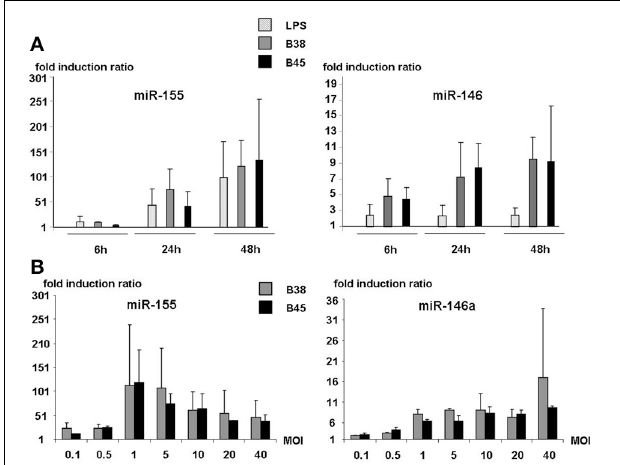
FIGURE 2 | MOI dependence and kinetic analyses of miR-146a and miR155 expression in activated dendritic cells. (A) DCs were either stimulated with E. coli LPS or cocultured with H. pylori strains B38 or B45 at MOI 1 for 6, 24, or 48h. (B) DCs were cocultured with H. pylori strains B38 or B45 at MOIs ranging from 0.1 to 40 for 48h. For both experiments, miRNA levels were determined by RT-qPCR. Data is presented as the fold induction ratio (mean + standard deviation of duplicate) of activated vs. non-activated DCs and is representative of one experiment out of 3.